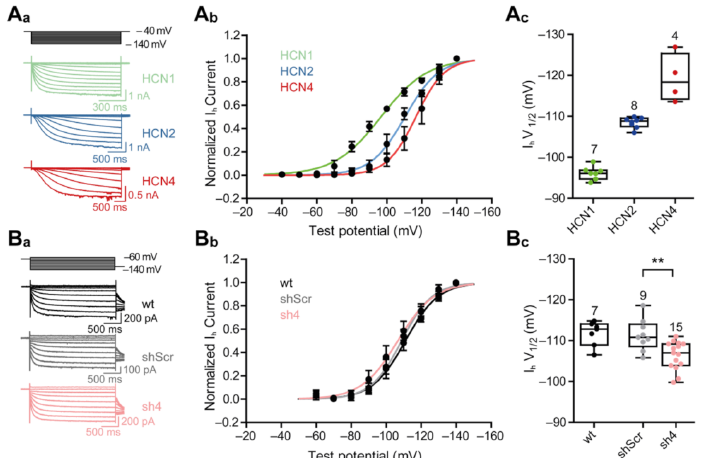
Figure 5. Knock-down of HCN-channel subunit four shifts half-maximal activation voltage of I h . ( A a ) Representative current traces of whole-cell patch-clamp recordings from − 40 to − 140 mV ( ∆ − 10 mV) of HEK293 cells constitutively expressing HCN-channel subunit 1, 2, or 4. ( A b ) Activation curves of HCN-channel subunits 1, 2 and 4 measured from steady-state currents. The continuous lines represent fits to the Boltzmann function of the data. ( A c ) Half-maximal activation voltages of the different HCN-channel subunits, converted from the Boltzmann functions of whole-cell currents. ( B a ) Representative current traces of whole-cell patch-clamp recordings from − 60 to − 140 mV ( ∆ − 10 mV) of wildtype (wt, non-transduced) primary hippocampal neurons (PHNs) or rAAV9-transduced eGFP-positive PHNs, either expressing sh4 or shScr. ( B b ) Activation curves of wt and transduced PHNs. The continuous lines represent fits to the Boltzmann functions of the data. ( B c ) Half-maximal activation voltages wt and sh4- or shScr-transduced PHNs, derived from the Boltzmann functions of whole-cell currents. The results are depicted as boxplots. Statistical significance was assessed using the unpaired two-tailed Student’s t test, ** p <